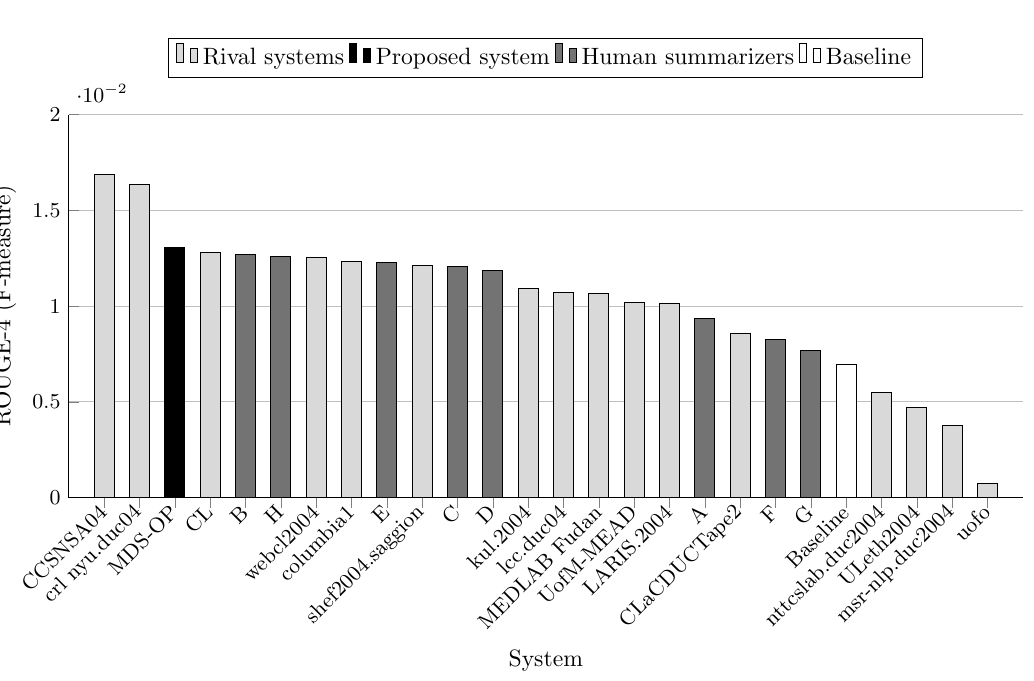
Figure 5. ROUGE-3 scores (F-measure) on DUC 2004 (Task 2).